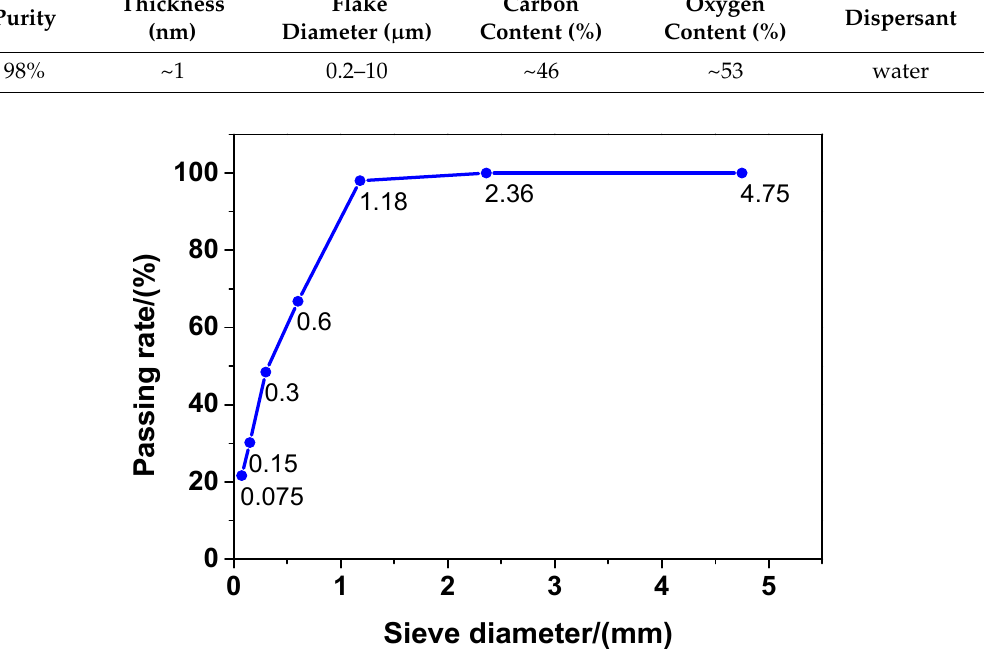
Figure 1. The particle size distribution of recycled sand.